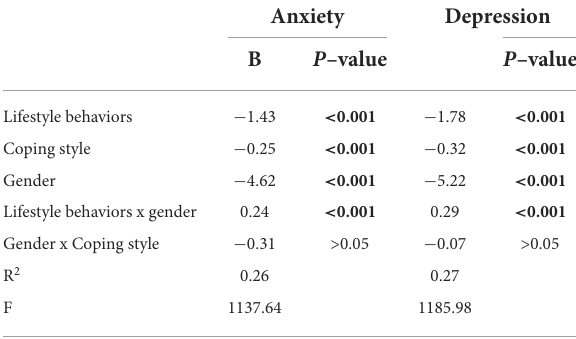
TABLE 6 Model characteristics for the conditional process